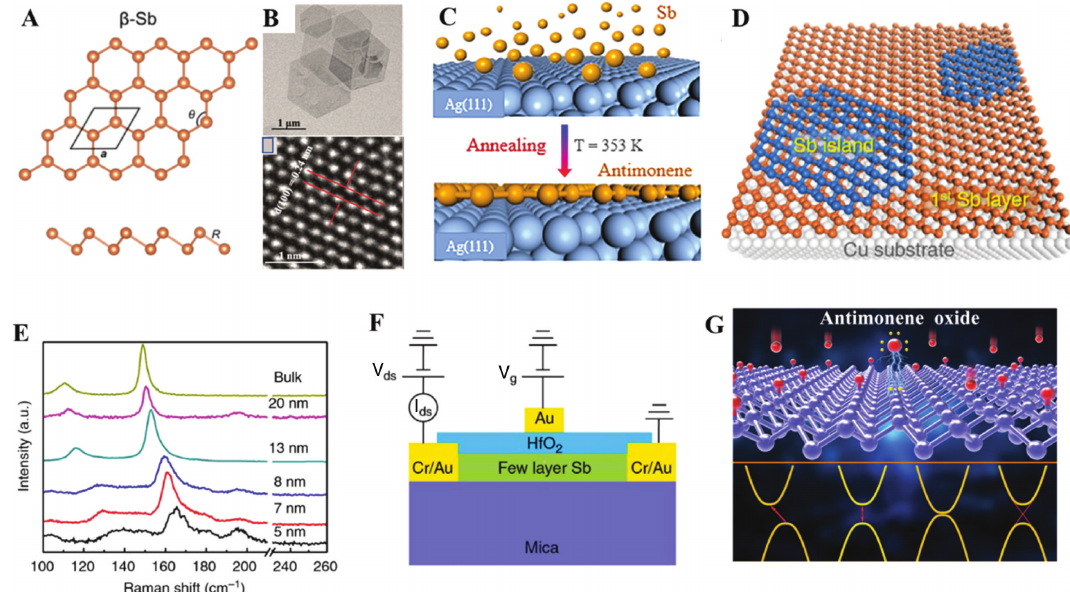
Figure 2: Structure, growth, physics and application of 2D Sb. (A) Structural configurations of antimonene allotropes β -Sb. Reproduced with permission from Ref. [88]. Copyright 2019, American Chemical Society. (B) TEM and HRTEM images of hexagonal antimonene nanosheets with a lattice spacing of 0.24 nm. Reproduced with permission from Ref. [89]. Copyright 2019, Wiley-VCH. (C) Schematic of fabrication process of antimonene on Ag (111) substrate. Reproduced with permission from Ref. [90]. Copyright 2018, American Chemical Society. (D) Structural model of the buckled antimonene monolayer (orange) and antimonene nanoisland (blue) on Cu (111) substrate. Reproduced with permission from Ref. [91]. Copyright 2019, American Chemical Society. (E) Raman spectra of antimonene polygons with thicknesses varying from 5 nm to bulk. (F) Schematic illustration of top-gated antimonene thin film transistors. (E, F) Reproduced with permission from Ref. [92] Copyright 2016, Springer Nature. (G) Sketch map of antimonene oxide. The bottom panel represents the electronic band structure of antimonene oxides with the different oxygen concentration. Reproduced with permission from Ref. [93]. Copyright 2017, American Chemical